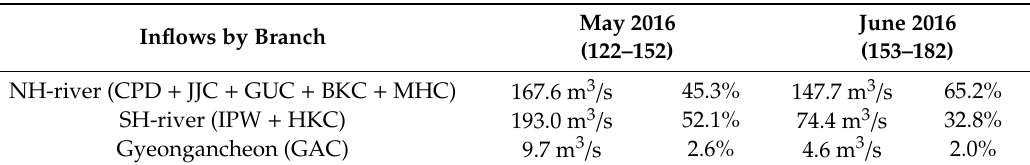
Table 2. Comparison on flow rates and the proportions of main inflows on Julian day 122 to 152 (May 2016) and 153 to 182 (June 2016).